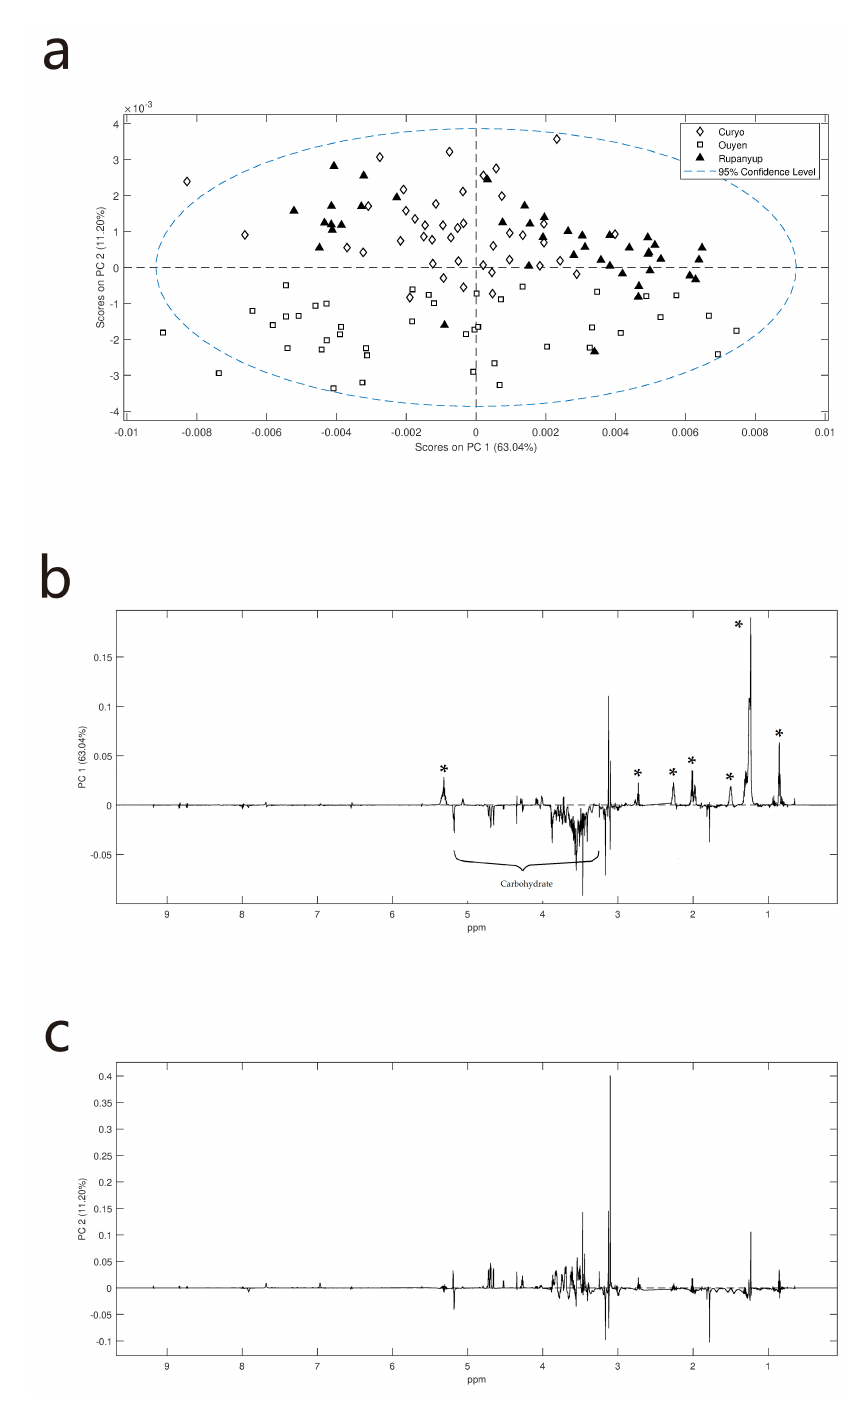
Figure 3. PCA scores and loading plots for 1 H NMR data of lentil cotyledon: ( a ) PCA scores plot showing some separation based on site in PC2; ( b ) loadings plot of PC1 variables suggest that major variation is in lipids (* in positive PC1) and carbohydrate (resonances between 3.2–5.2 ppm for negative PC1) levels; ( c ) loadings plot of PC2 variables suggest that major variation is in trigonelline and carbohydrate